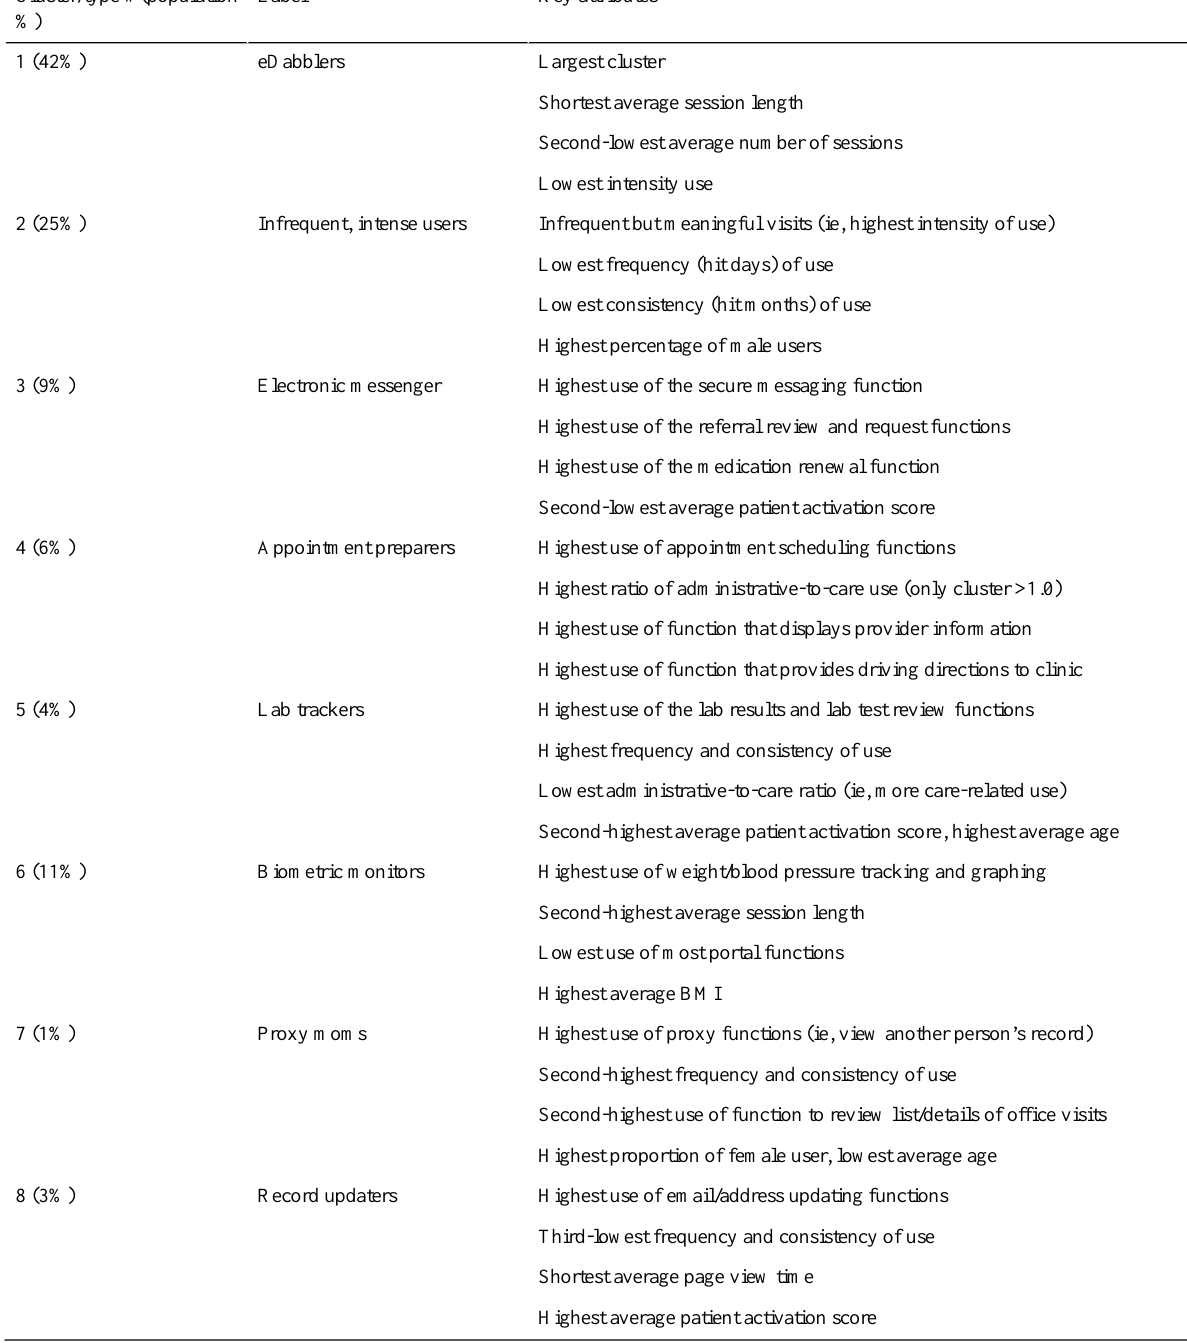
Key attributesLabelCluster/type #